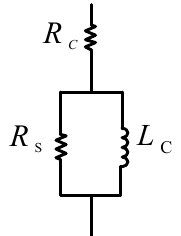
8 of 18 Figure 4. The main soil components. Soil_Ionization Z g R arc R air C Figure 5. Complete model of soil ionization behavior. 4.3. Circuit Based FRVF Model The basic circuit model as shown in Figure 6 is used to introduce the grounding grid high- frequency behaviors for many years. The passive parameters of resistance, inductance, and capacitance (RLC branch) are found in (32)–(35) [9–15].